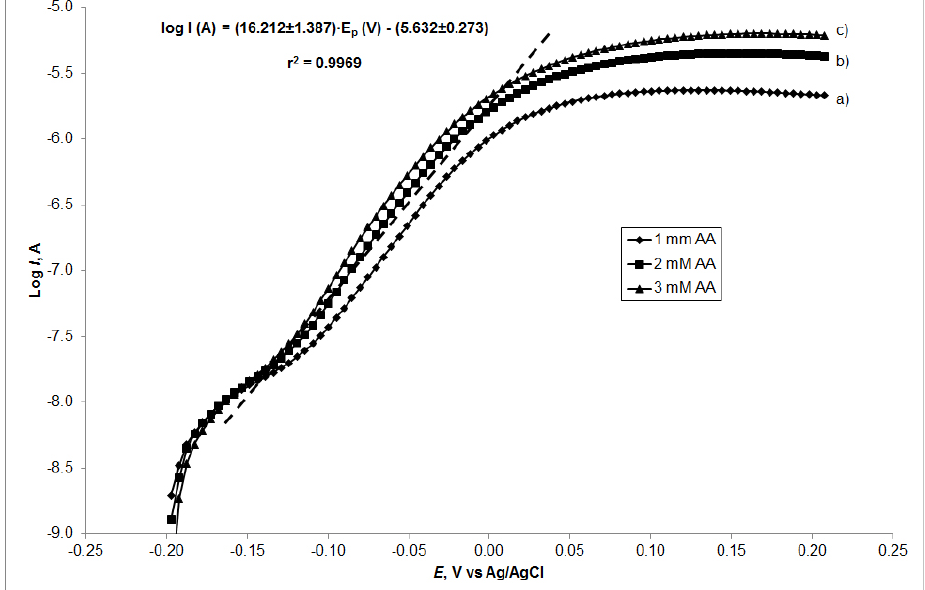
Figure 6. Tafel plots derived from current–potential curves obtained on the (2.5% w/w)-modified SNGC electrode in the presence of different AA AuSNPs/CeO 2 concentrations: ( a ) 1, ( b ) 2 and ( c ) 3 mM at a scan rate of 50 mV·s − 1 in PBS 0.2